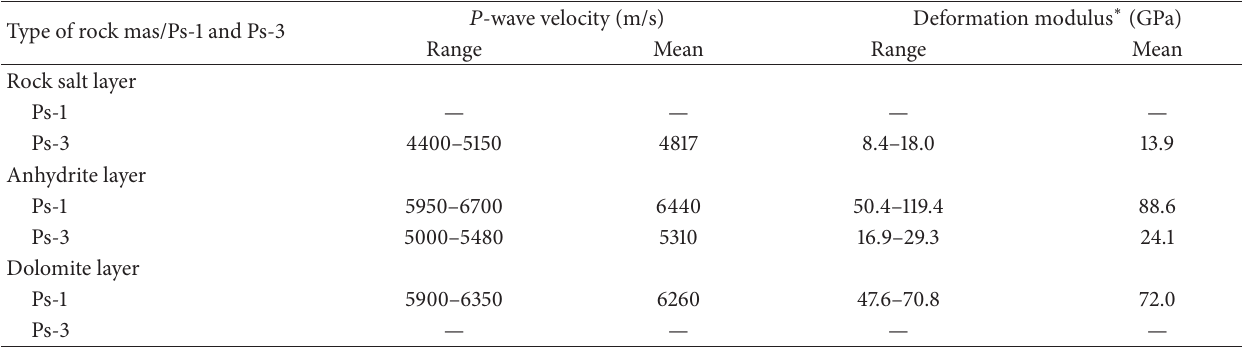
Table 1: Seismic properties of rock mass in two galleries: Ps-1 and Ps-3 [13]. Type of rock mas/Ps-1 and Ps-3